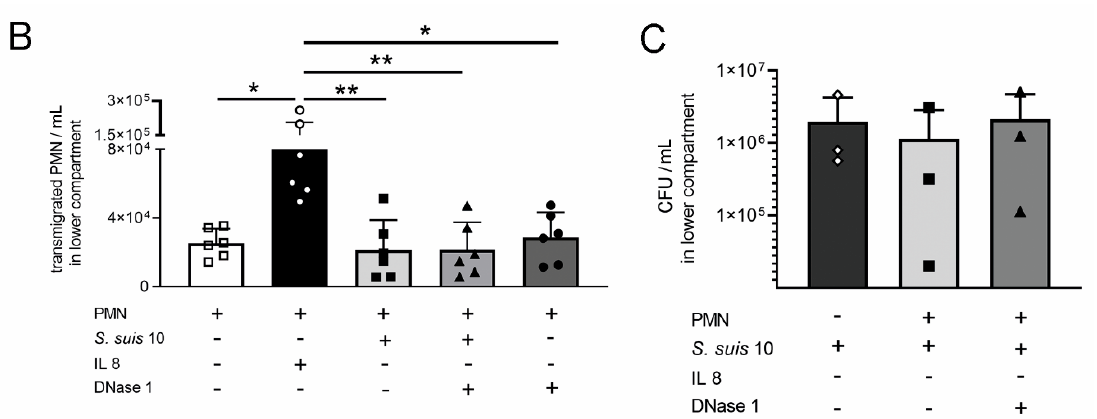
Figure 5. DNase 1 has no impact on transmigration of isolated porcine neutrophils through a cell layer of porcine choroid plexus epithelial cells and killing of S. suis by neutrophils. ( A ) An inverted cell culture model with porcine choroid plexus epithelial (PCP-R) cells was used to investigate transmigration of neutrophils after infection with S. suis . PCP-R cells were grown on the underside of a filter insert with 3 µ m pores. S. suis 10 transmigrated from the blood compartment at the basolateral side into the medium-filled CSF compartment at the apical side of PCP-R cells. The medium with bacteria in the blood compartment was removed and replaced by medium containing freshly isolated porcine neutrophils (polymorph nuclear cells (PMN)). Neutrophils were allowed to transmigrate through the cell layer for 4 h and counteract against S. suis in the CSF compartment. As read-out neutrophil / mL and CFU / mL were determined. ( B ) Stimulation with 100 ng / mL interleukin 8 (IL8) leads to high transmigration of neutrophils into the CSF compartment in the cell culture system. ( C ) The CFU / mL was not significantly influenced by transmigrated neutrophils with or without DNase 1 treatment. ( + ) component present in the well, ( − ) component not present in the well. Data shown as mean ± SD; n = 3 independent experiments in duplicates. Statistical analysis: one-way ANOVA followed by Kruskal–Wallis multiple comparison test (* p < 0.05, ** p < 0.01).